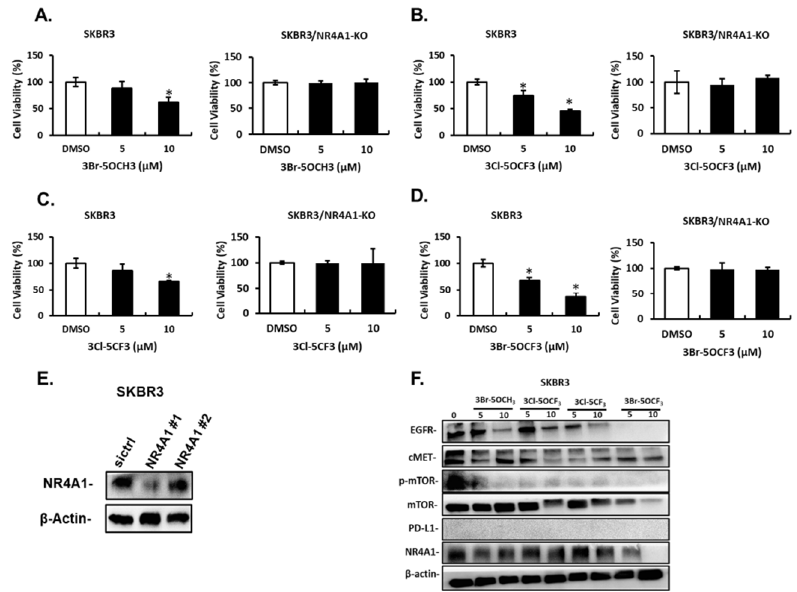
Figure 4 . Effects of 3,5-disubstituted phenyl CDIM analogs on SKBR3 cell viability and NR4A1- regulated gene products. SKBR3 cells were treated with 3-Br-5-OCH 3 ( A ), 3-Cl-5- OCF 3 ( B ), 3-Cl-5- CF 3 ( C ), and 3-Br-5- OCF 3 ( D ) for 24 h and effects on cell proliferation were determined in cells expressing NR4A1 and after the NR4A1 knockdown, as outlined in the Materials and Methods section ( E ). Cells were transfected with oligonucleotides targeting NR4A1, and after 72 h whole cell lysate were analyzed by western blots ( F ). (NR4A1 #1 used above) Cell lysates from SKBR3